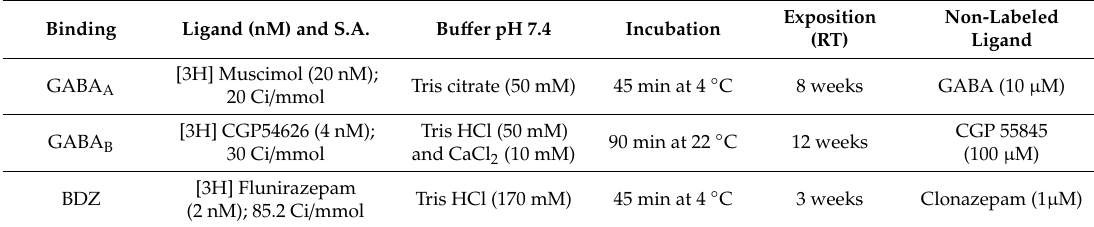
Table 2. Conditions for the autoradiography